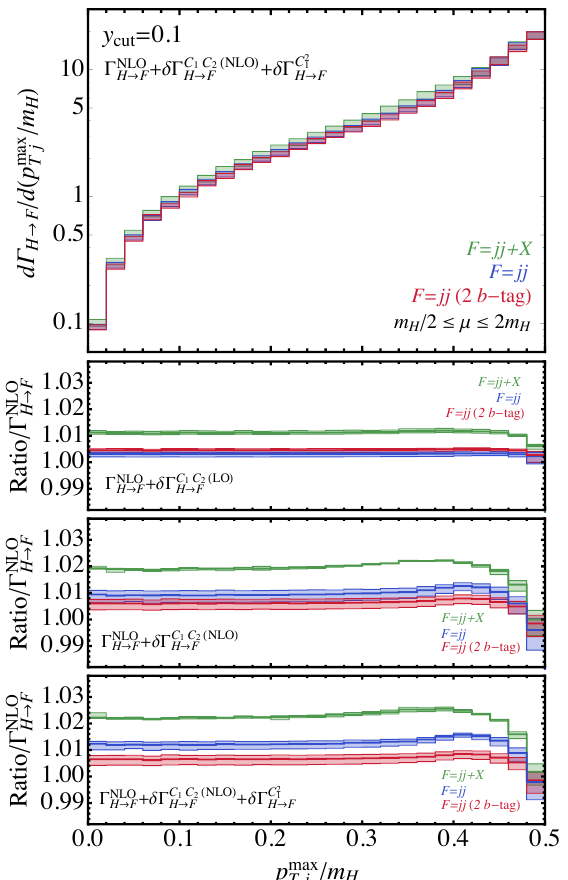
Figure 5. Differential predictions for the (fractional) transverse momentum (with respect to a fictitious collision axis ± ˆ z ) of the leading jet, clustered with y cut = 0 . 1 . Results are presented for a variety of different requirements on the final state jets, either no restrictions H → jj + X (green), requiring exactly two jets H → jj (blue) or exactly two b -tagged jets H → bb (red). The lower panels present the impact of the mixed EFT- y b piece at O ( α 2 ) , O ( α 3 ) , and the combined EFT- y b s s and EFT 2 piece at O ( α 3 ) , with respect to the NLO y 2 prediction. s b